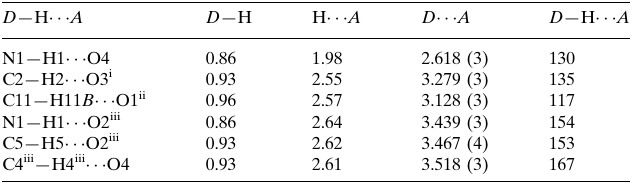
Hydrogen-bond geometry (A˚ , (cid:4)